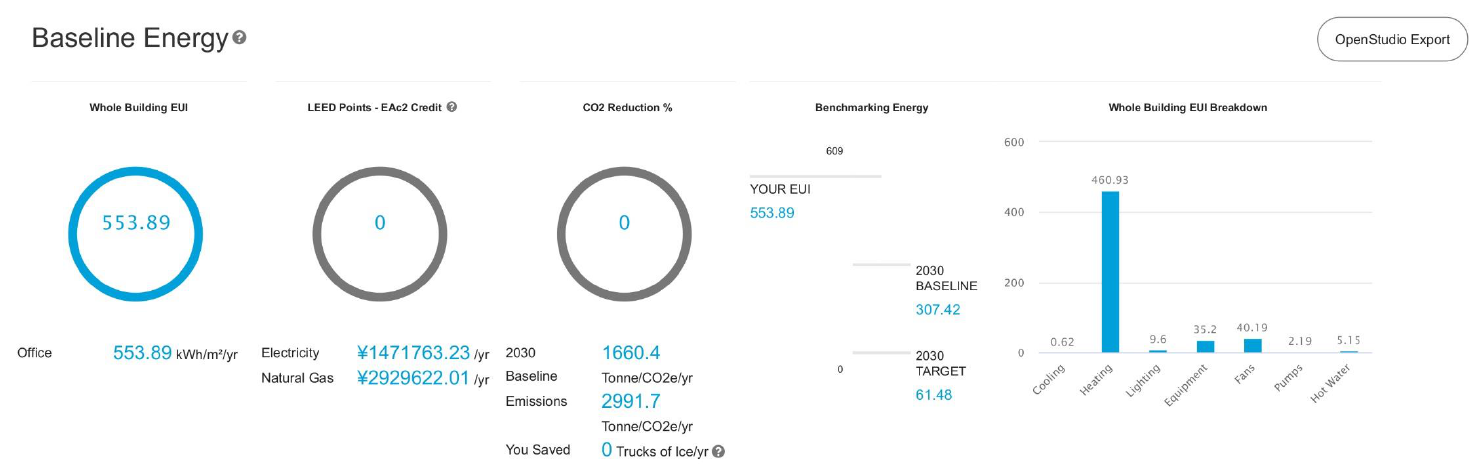
Clean Technol. 2022 , 4 , FOR PEER REVIEW Figure A35. Zone 6-B Ordos, Nei Menggu (post-COVID-19 78% scenario). Figure A35. Zone 6-B Ordos, Nei Menggu (post-COVID-19 78% scenario).